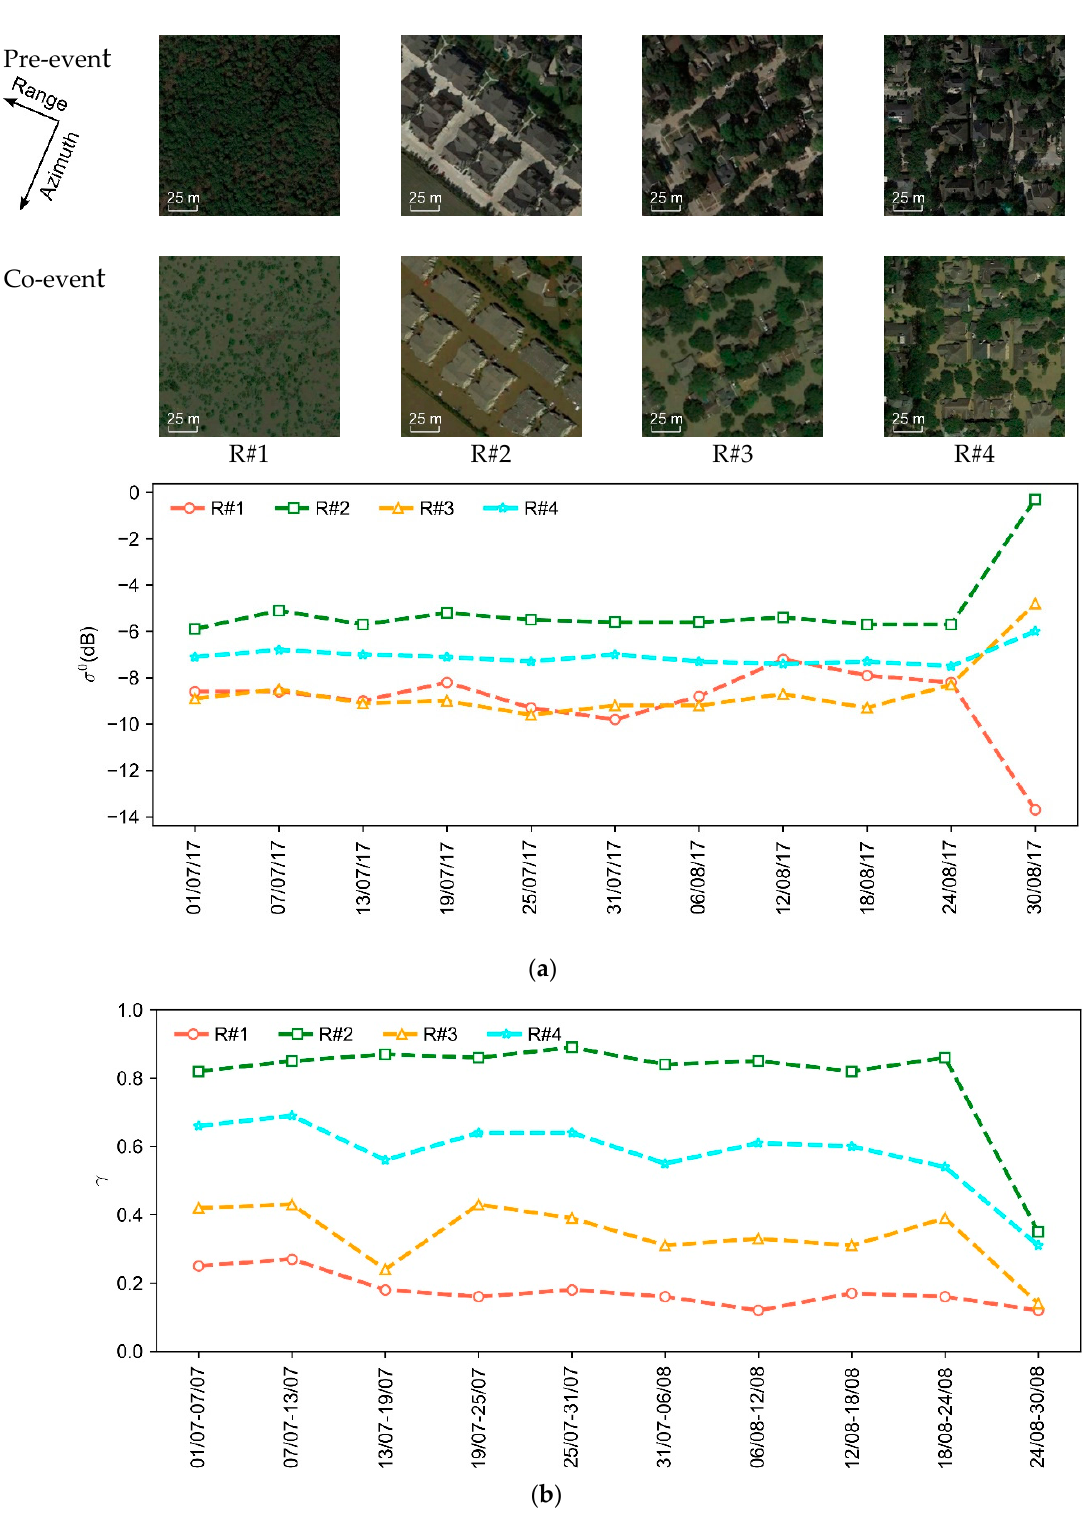
Figure 4. Sentinel-1 σ ° and γ temporal variation for several typical landscapes within the Houston study area: ( a ) σ ° temporal trends; ( b ) γ temporal trends.